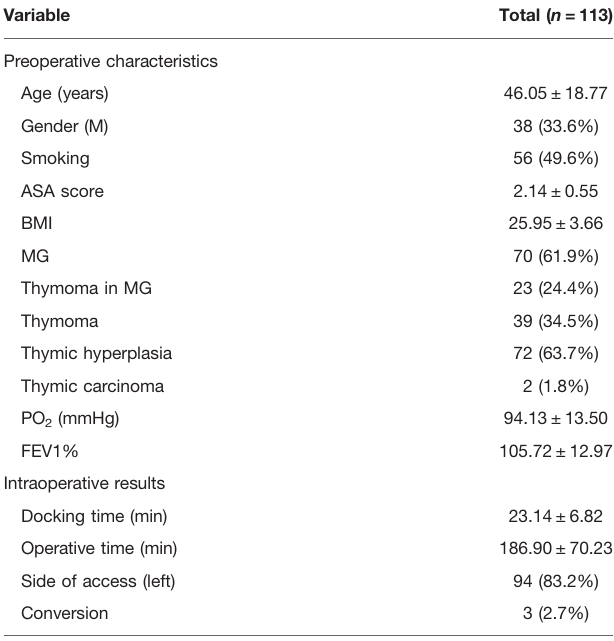
TABLE 1 | Clinicopathological characteristics of patients of the entire